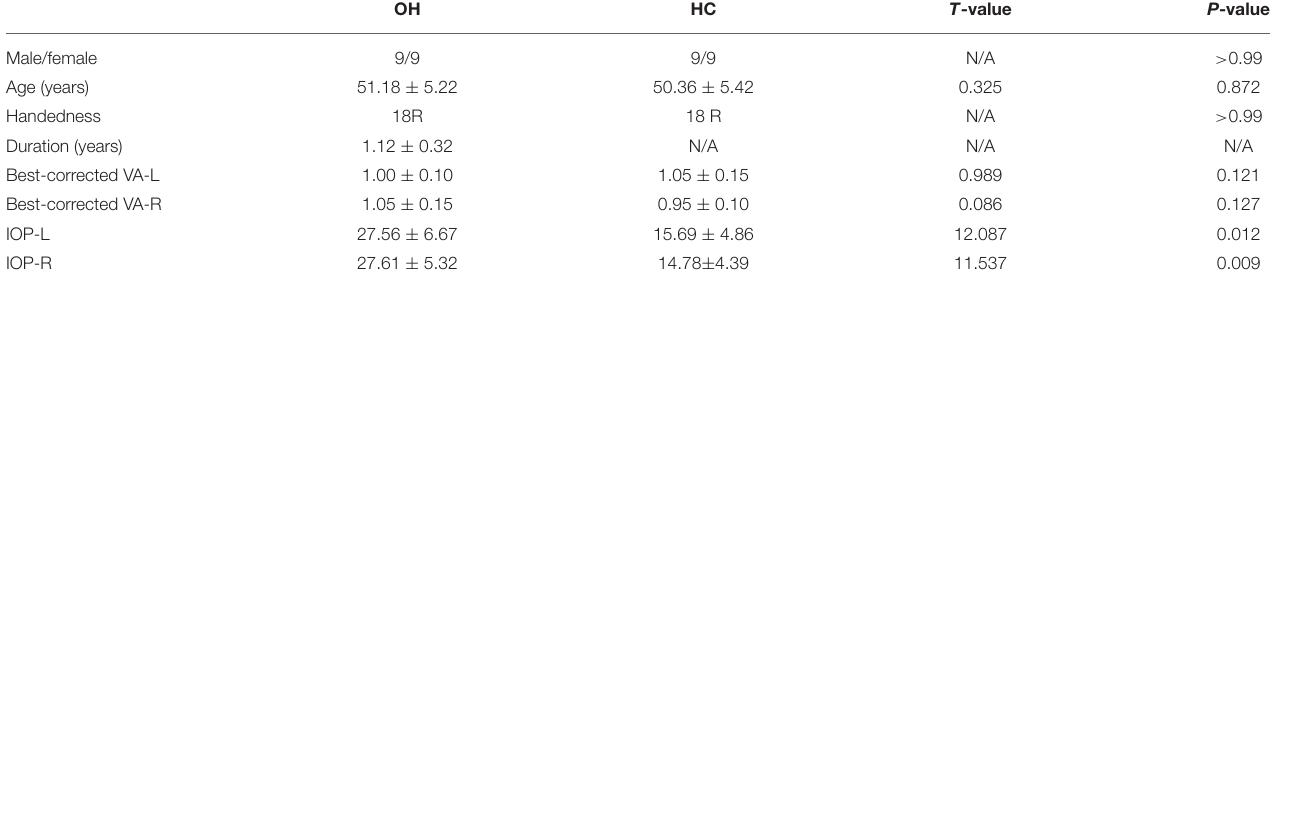
TABLE 2 | Demographics and behavioral results of OH and HCs groups. OH HC T -value P